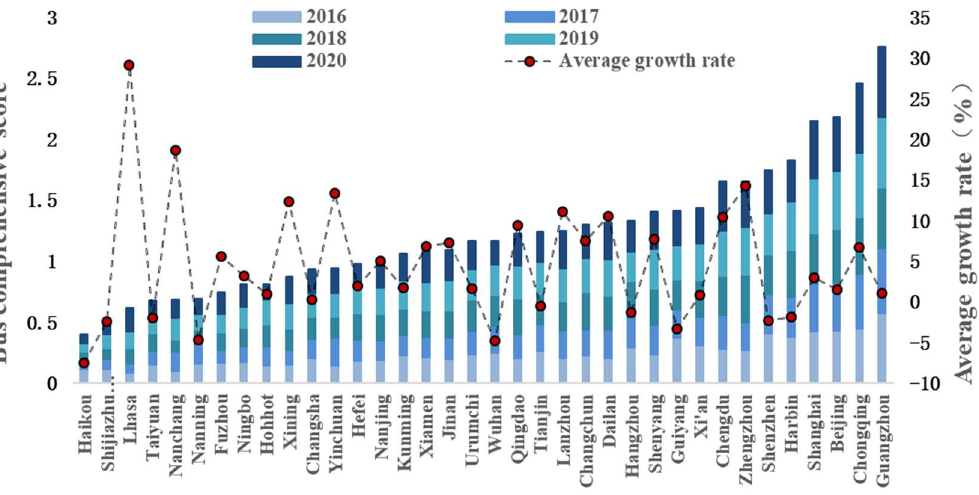
Figure 2. Changes in the comprehensive development level of buses in 36 cities in China.